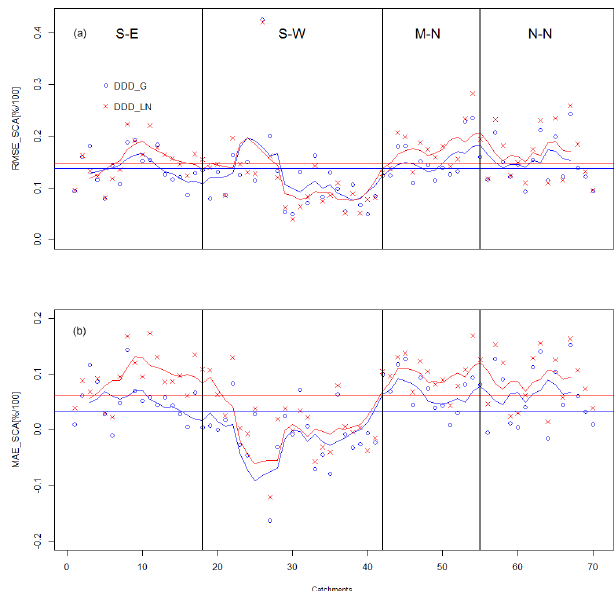
Figure 8. (a) Root mean square error (RMSE) for simulated SCA for DDD_G (blue) and DDD_LN (red). (b) Mean absolute error (MAE) for simulated SCA for DDD_G (blue) and DDD_LN (red). Moving averages and mean values of RMSE and MAE are shown with the same colour